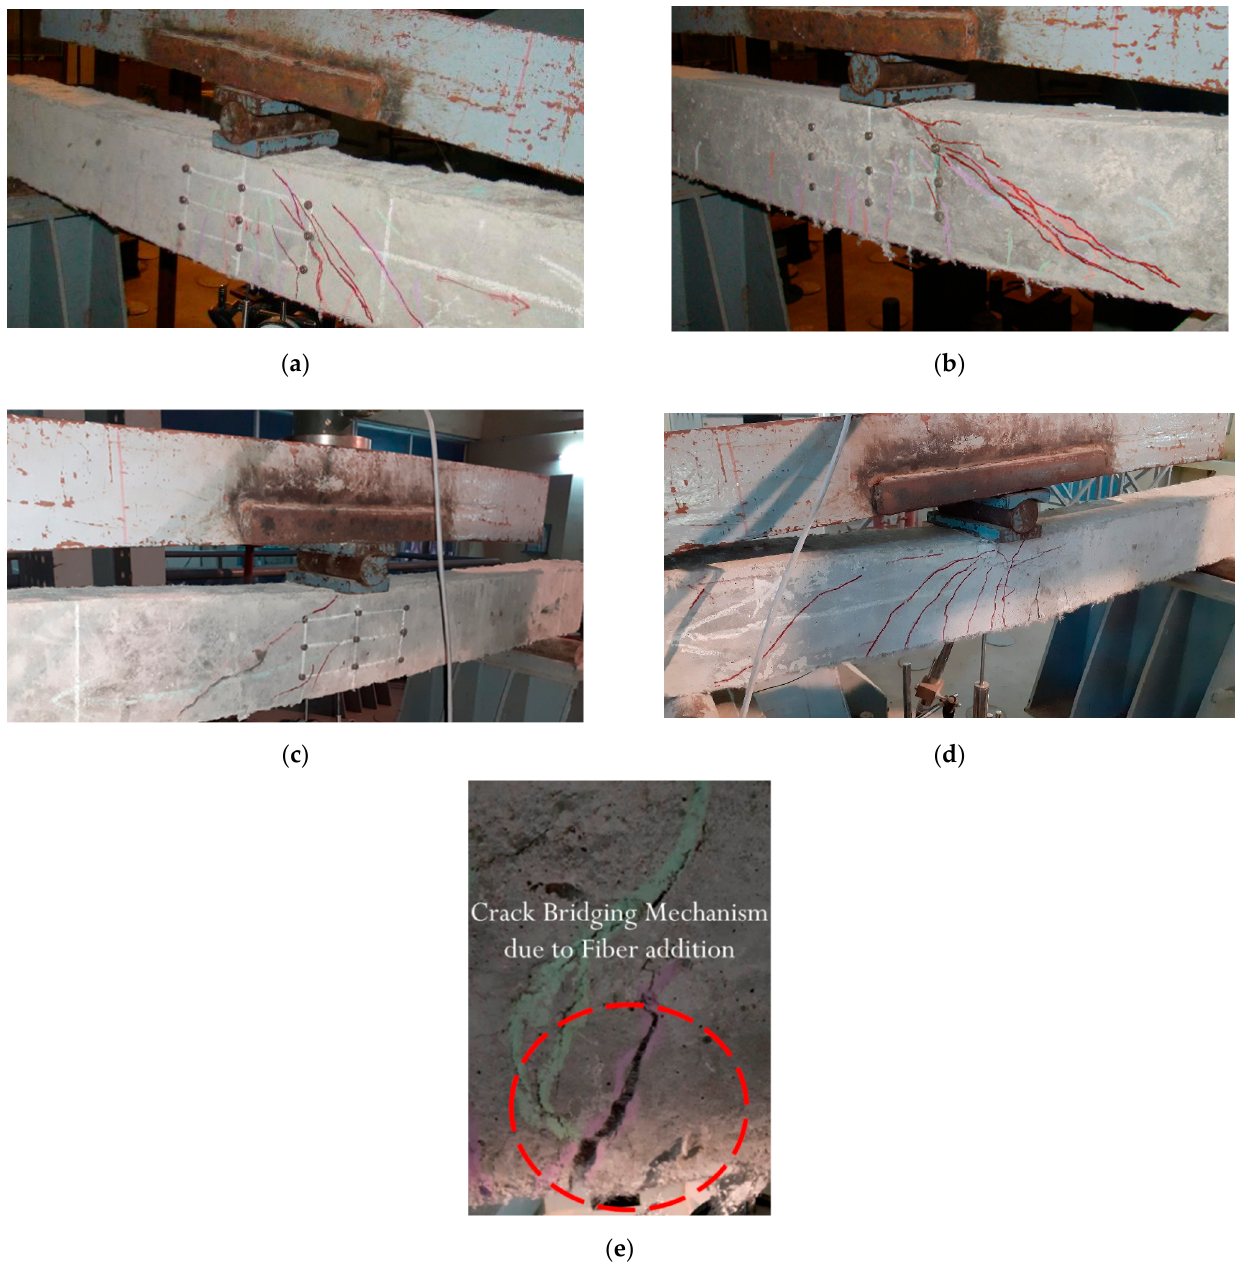
Figure 9. Experimental failure modes of ECC specimens with different fiber additions: ( a ) ECC—PVA, ( b ) ECC—PP, ( c ) ECC—ST, ( d ) ECC—HYB, ( e ) hybrid PVA + PP effects.